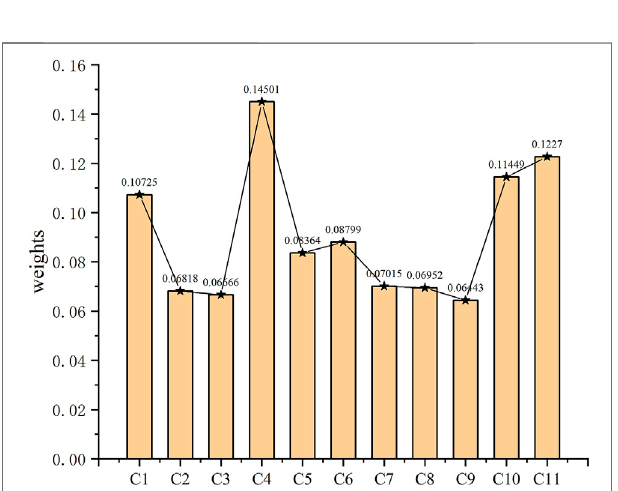
FIGURE 3 | Weight value of each index obtained by EWM in planning stage 1.